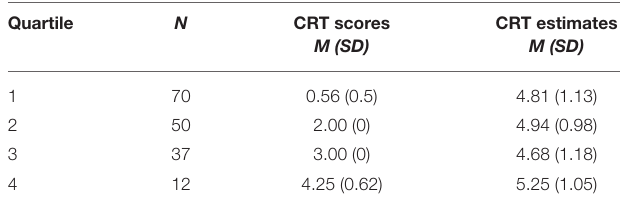
TABLE 1 | Descriptive Statistics [ M ( SD )] for actual CRT scores, estimated CRT per